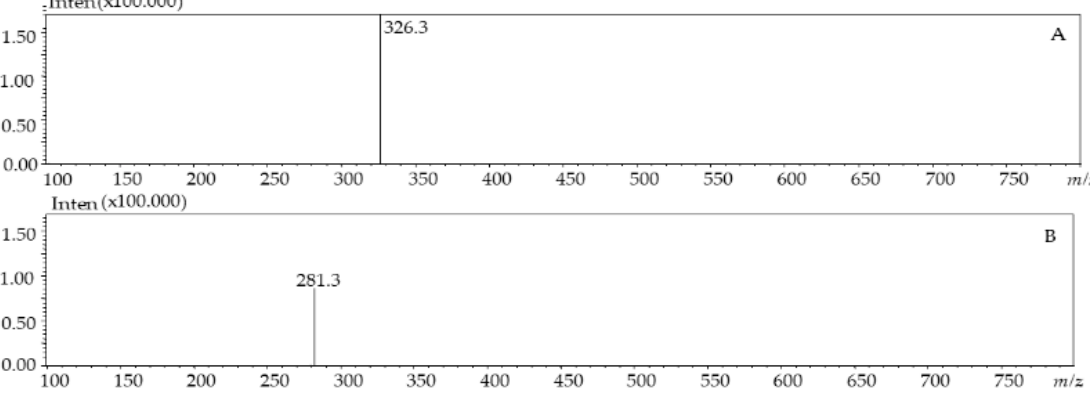
Figure 2. LC–MS (ESI - ) profile ofp-coumaroyl tyrosine from P. tricornutum ( A ) and dimethoxyflavone from T. suecica species ( B